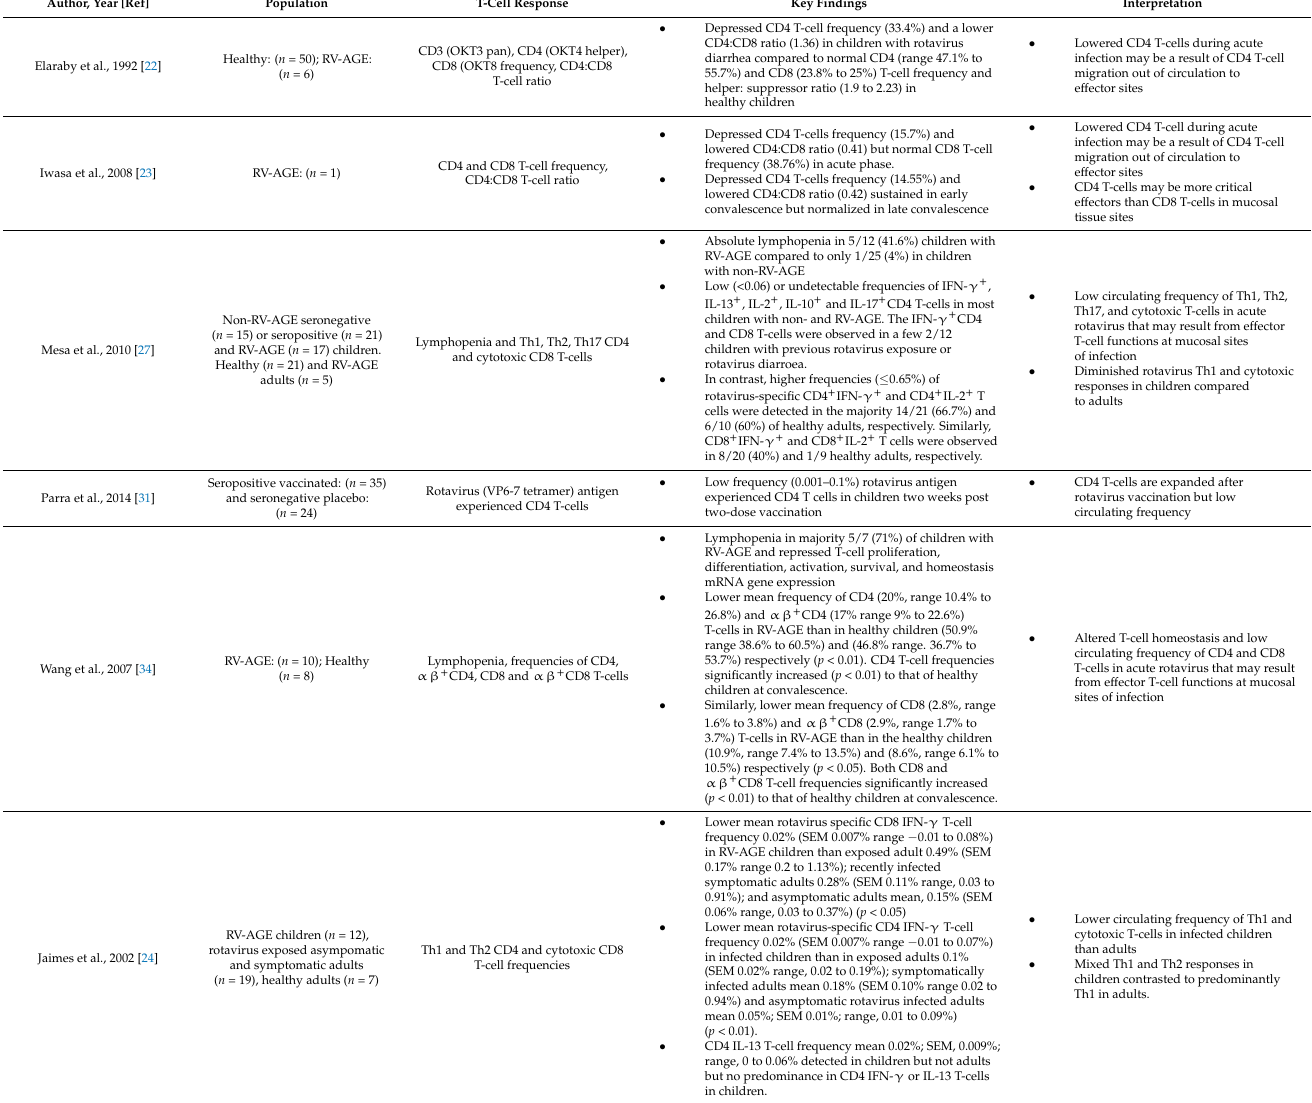
Table 4. Proliferative, Helper, and cytotoxic T-cell frequency to rotavirus in children compared to adults and other